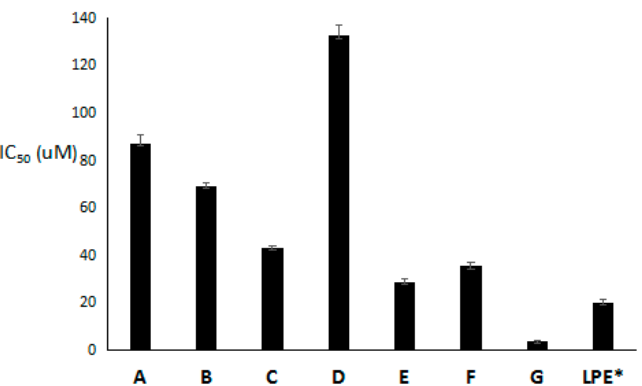
Figure 3. Inhibitory effect of LPPs and purified LPE on A549 cells. (A-protocatechuic acid, B-isoscopoletin, C-quercetin, D-ellagic acid, E-corilagin, F-proanthocyanidins C1, G-5-fluorouracil, LPE-longan pericarp extract, * 20.0 ± 1.5 mg · mL − 1 ).